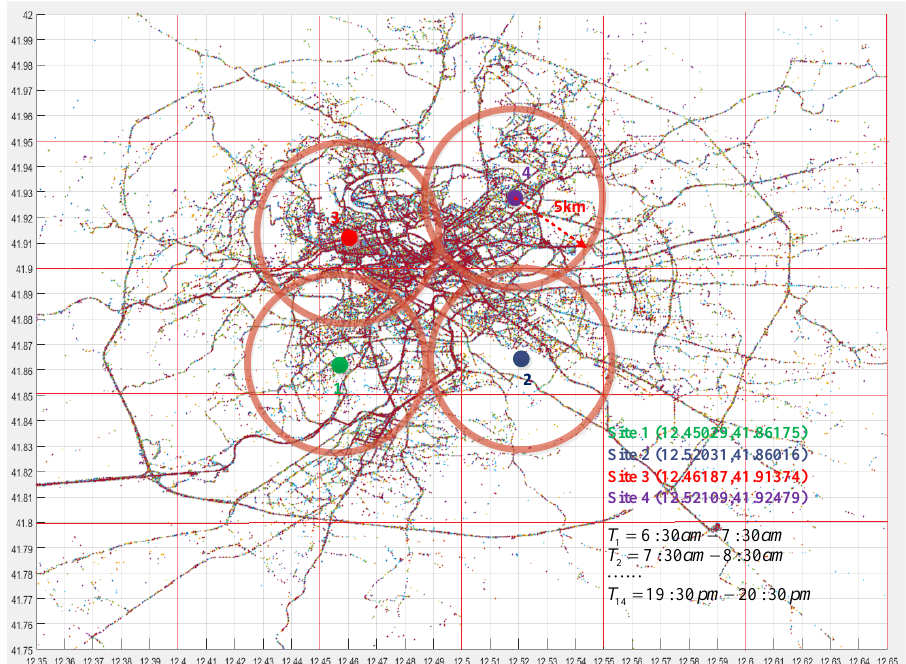
Figure 8. Some simulation parameters